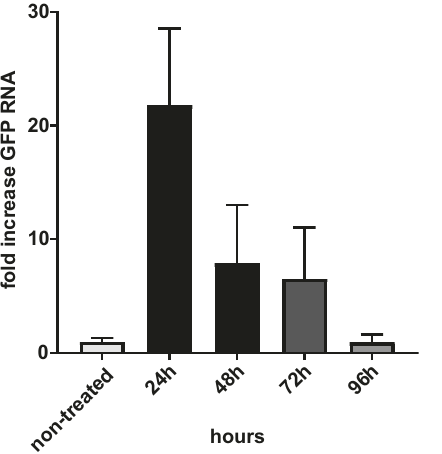
Fig. 2 Time course of GFP RNA expression in mouse skin after vaccination using IONAID. In all, 100 µg of reporter gene plasmid coding for eGFP was delivered in the back skin of C57BL/6 mice. Total RNA was extracted from skin specimens and eGFP mRNA was quanti fi ed by qPCR at different times post vaccination. Results are expressed as fold increase relative to non-treated skin specimens. Data shown represent the means ± SEM of three animals per group.